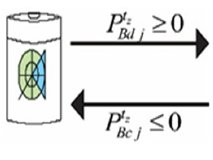
Figure 3. Battery Figure 3. Battery model.